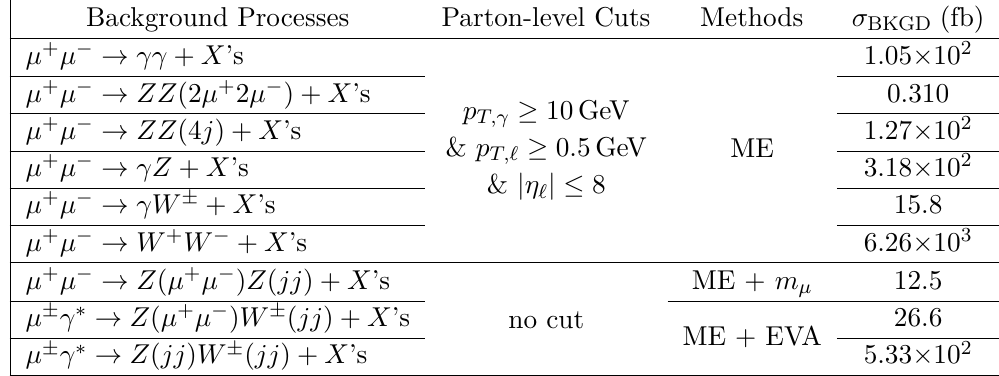
Table 1 . Summary of cuts and cross sections for SM backgrounds simulated by MadGraph : γ ∗ denotes a partonic photon from the muon beam, and X ’s denote the beam remnants, including muon, muon neutrino, and their antiparticles. The background cross section σ BKGD is understood to include branching fractions to all secondary decays indicated in the parentheses. Decay products from Z ’s and W ’s are not subject to parton-level